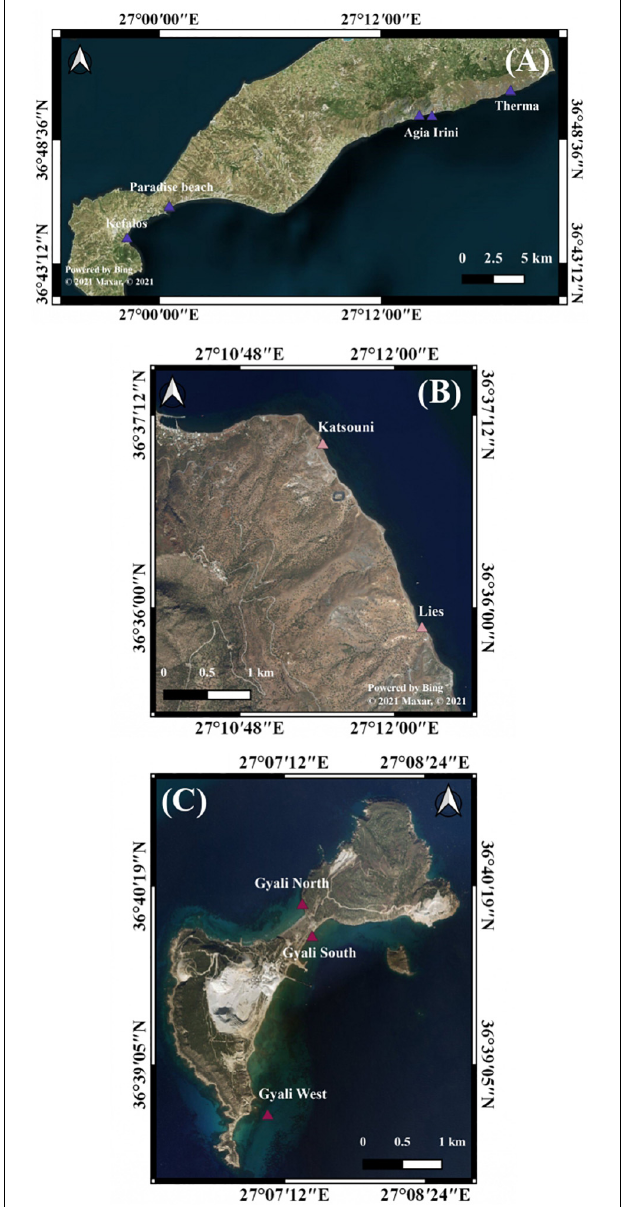
FIGURE 4 | (A) Map of the southern sector of Kos Island that shows the locations and names of the emission points. (B) Map of the NE sector of Nisyros Island that shows the locations and names of the emission points. (C) Map of Gyali Island that shows the locations and names of the emission